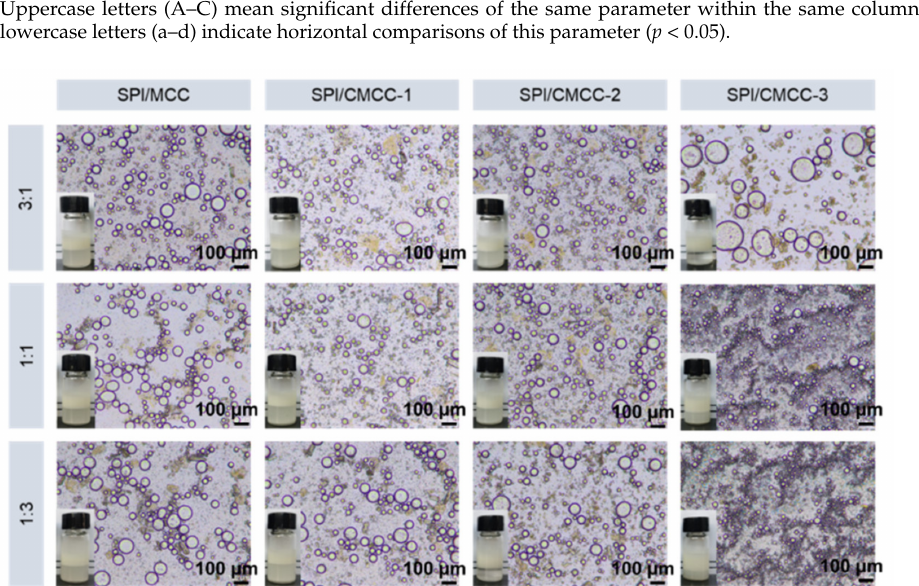
Figure 4. The microscope observation of emulsion stabilized by complexes of SPI and MCC/CMCC at ratios of 3:1, 1:1, and 1:3 (from up to